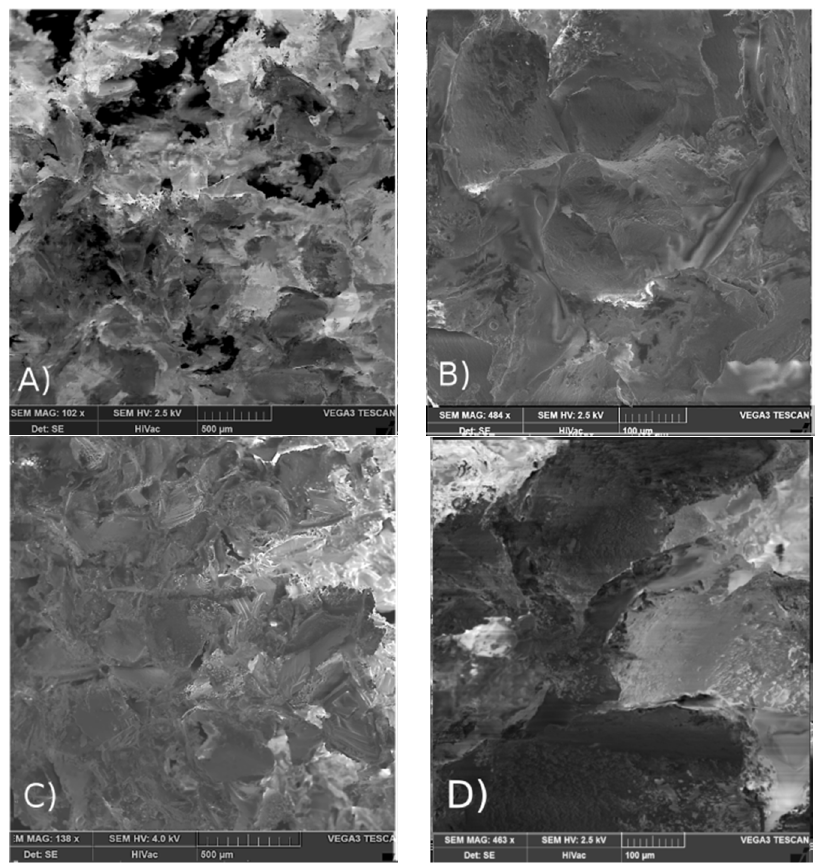
Figure 2. SEM pictures of porous surface of scaffold LGC C: ( A , B ) before sterilization; ( C , D ) after γ irradiation with a 25 kGy dose.